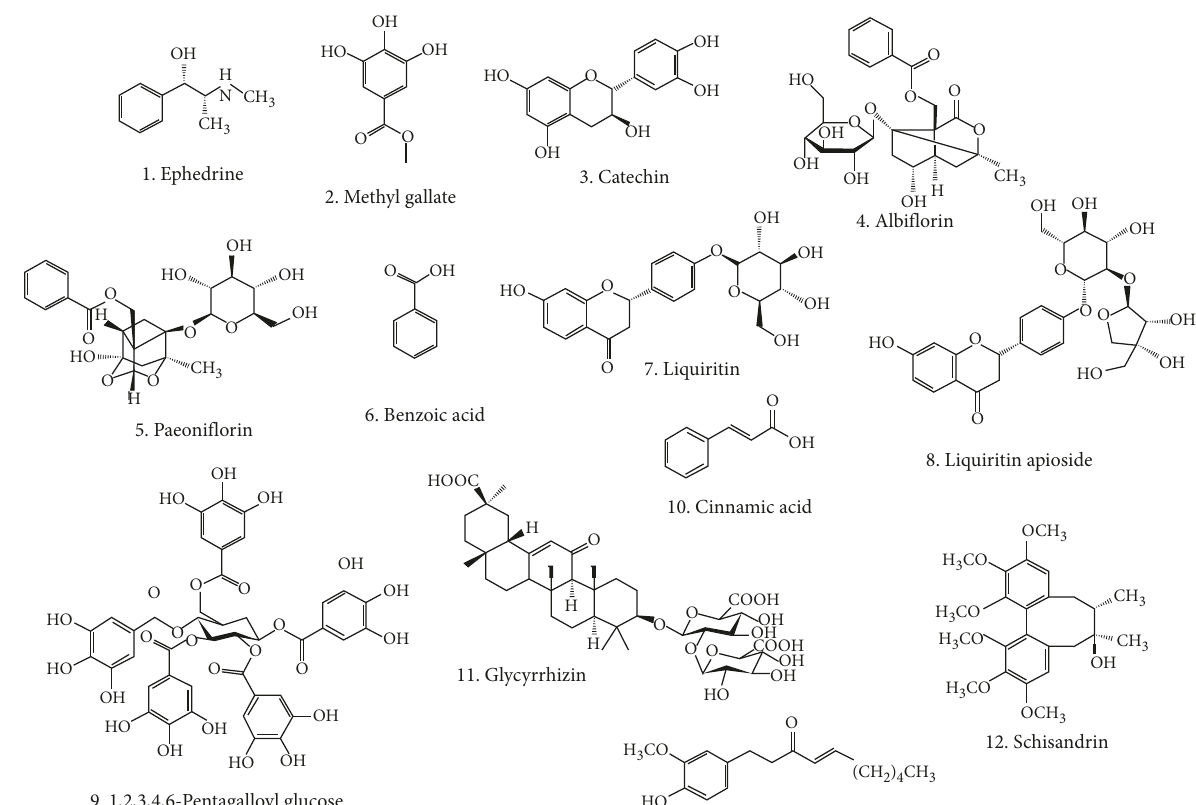
Figure 1: Chemical structures of the 13 marker